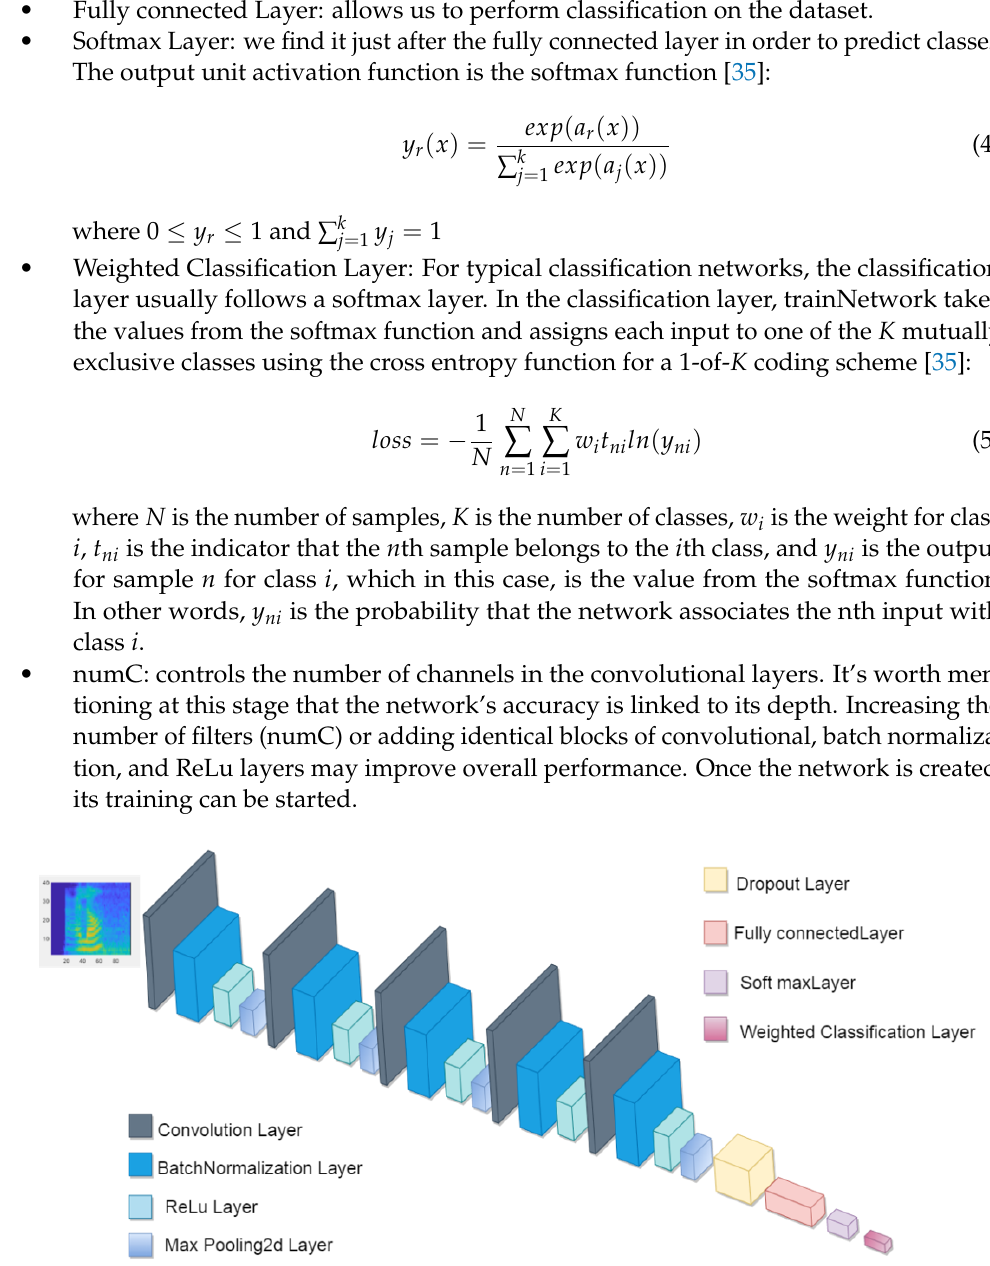
Figure 5. Deep neural networks